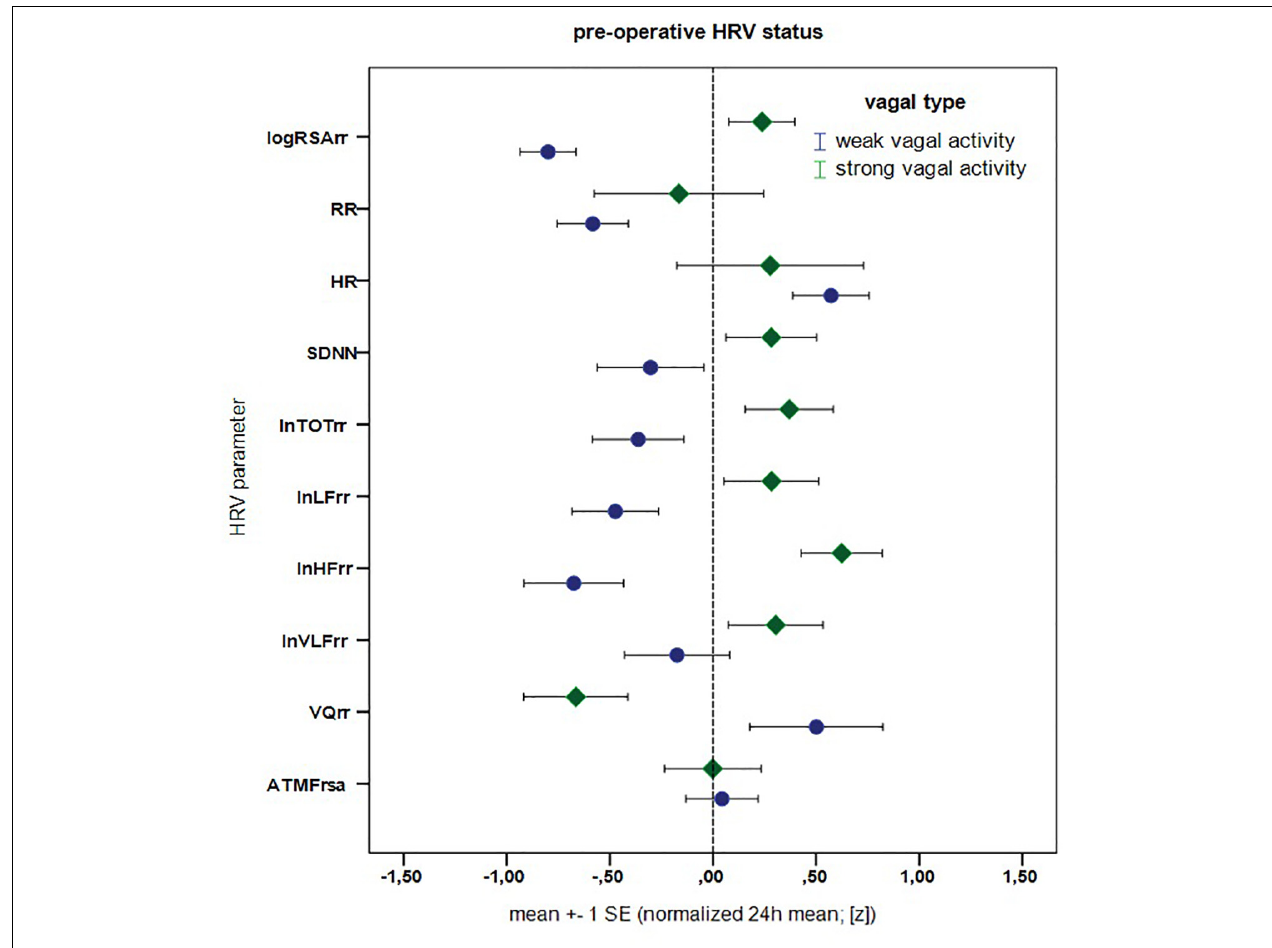
FIGURE 5 | Pre-operative cardio-autonomic status - patients with weak vs. stronge vagal activity. Mean (absolute) z -difference (weak vs. strong vagal activity) = 0.759, T = –2.936 (df = 14), p = 0.011 ∗ (MANOVA: F = 3.113, p = 0.062, η 2 p = 0.675, calculated for HR, SDNN, TOT, LF, HF, VLF, and VQ).